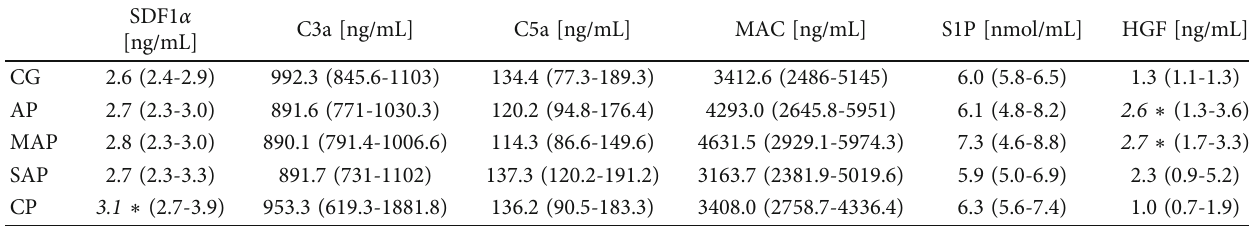
Table 4: The levels of chemoattractive factors in patients.